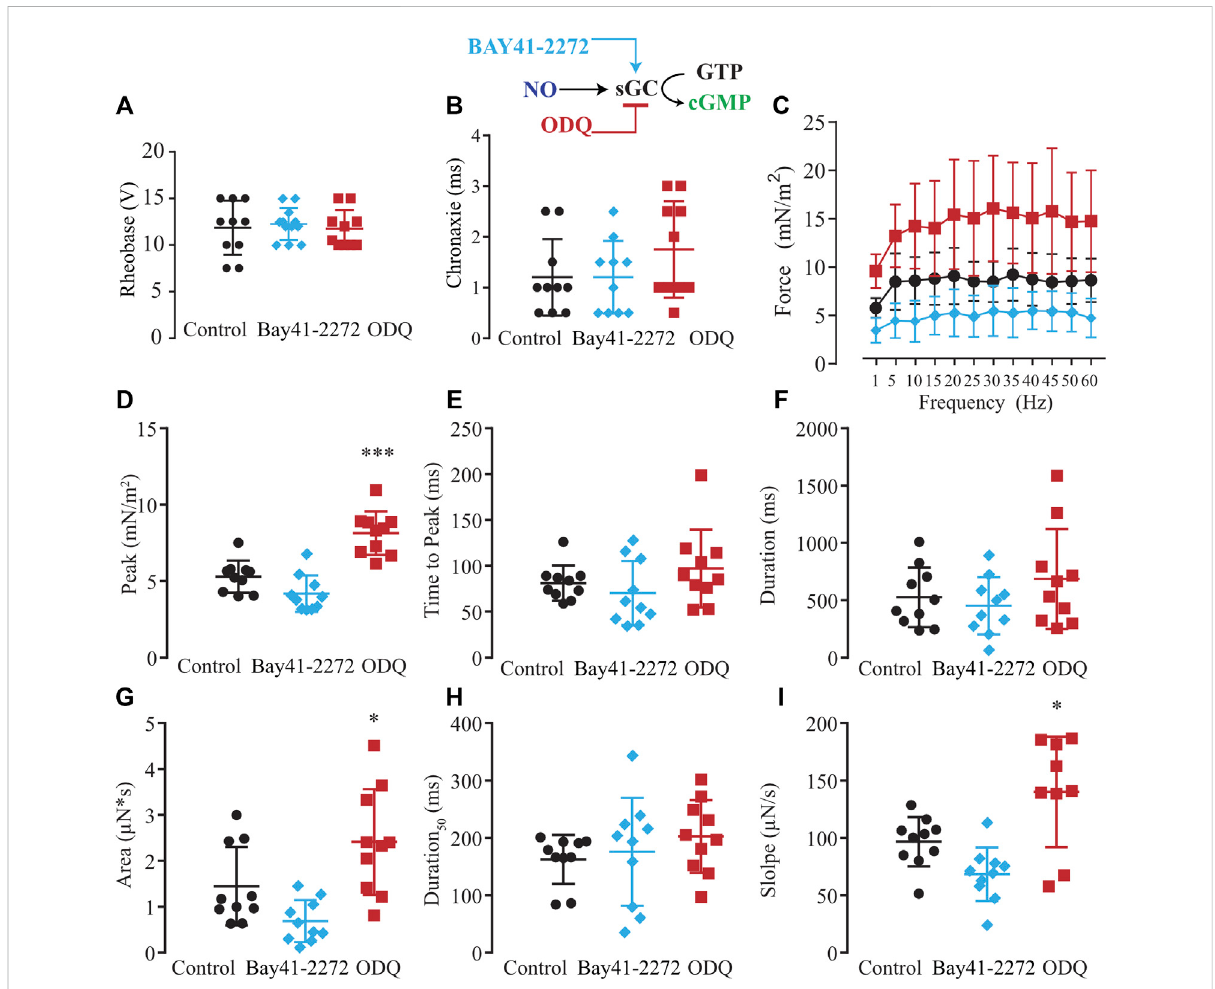
FIGURE 5 Summary of the effect of Bay41-2272 and ODQ on sGC ’ s role in myooid response to electrical stimulation. Myooids perfused with control solution are represented by the black color, light blue for myooids treated with sGC activator Bay41-2272, and dark red for those treated with sGC blocker ODQ. (A) Rheobase and (B) Chronaxie summarized the excitability of the myooids under subthreshold stimulation. (C) Force frequency protocol. (D – I) analyses of the biophysical parameters in response to single-twitch stimulation. Each condition contained ten myooids and the symbols * and *** represent the signi fi cant thresholds below 5% and 0.1%,